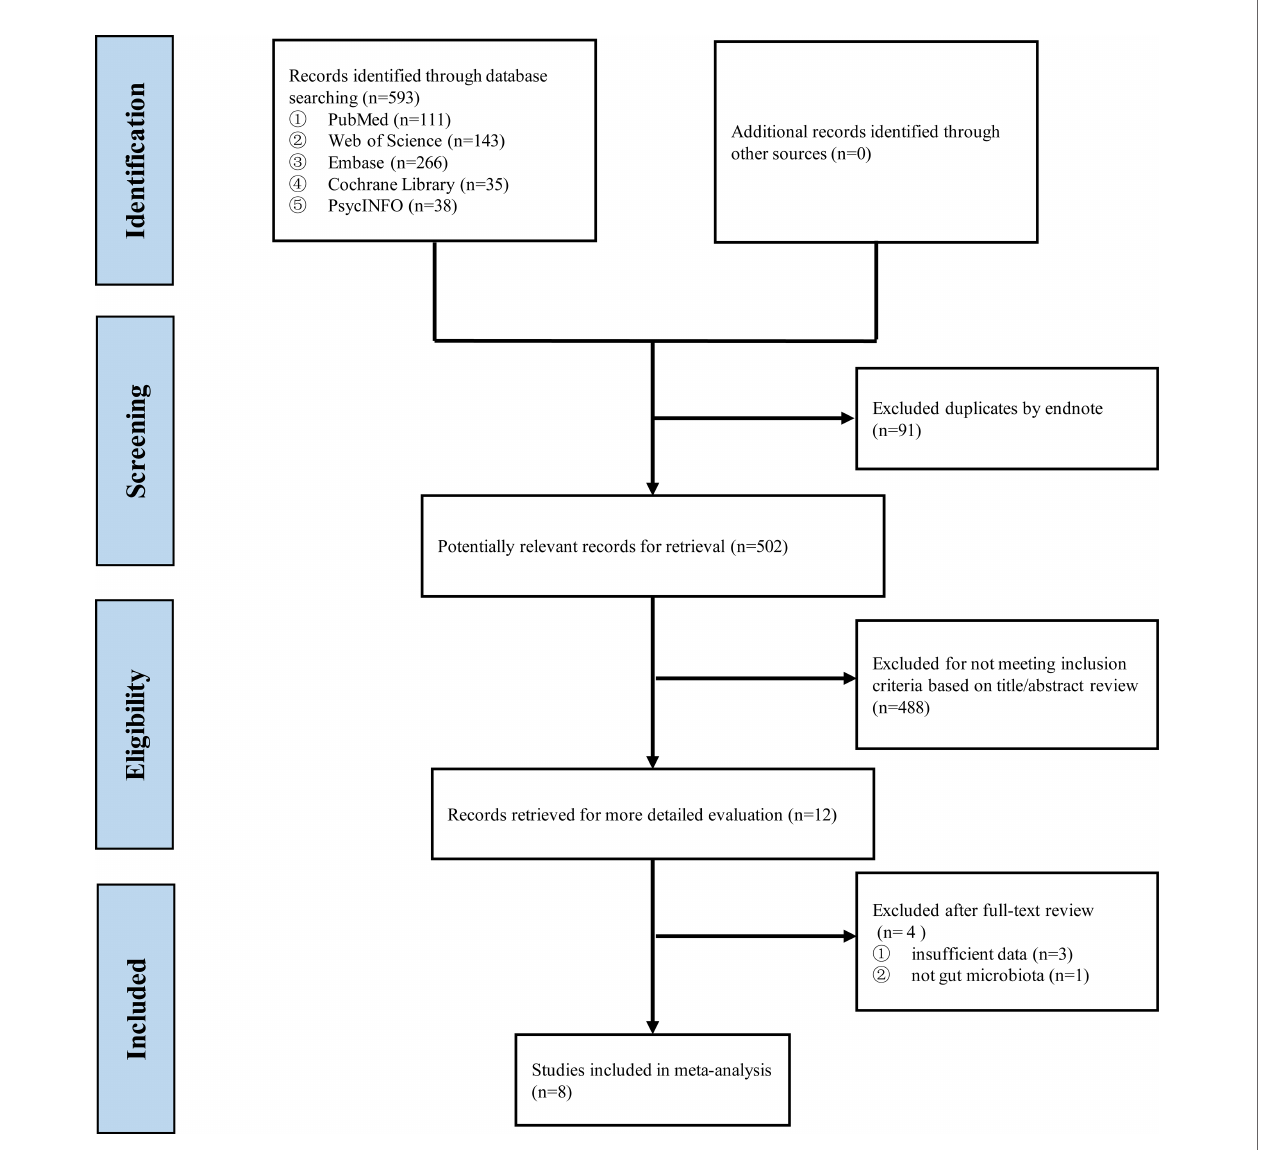
FIGURE 1 | Flow diagram of selected